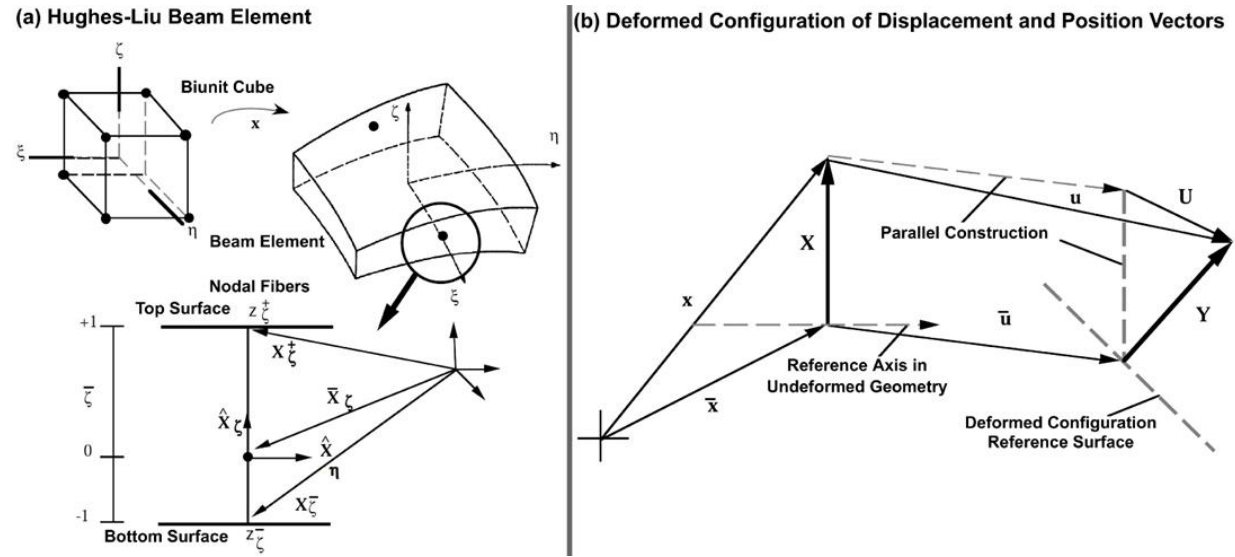
Figure 4. ( a ) Hughes-Liu Beam Element. ( b ) Deformed configuration of displacement and position vectors (LS-DYNA user manual: Open Access, Copyright is not required).